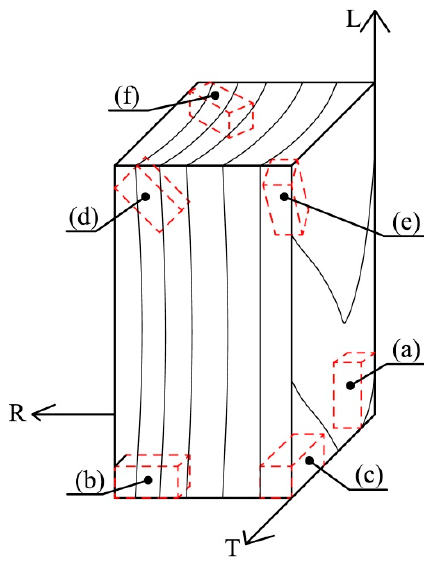
Figure 1. Cutting method of samples used to measure elastic constants, (a) to (f) correspond to those in Figure 2. (L, R, and T are longitudinal, radial, and tangential grain orientations of European been).